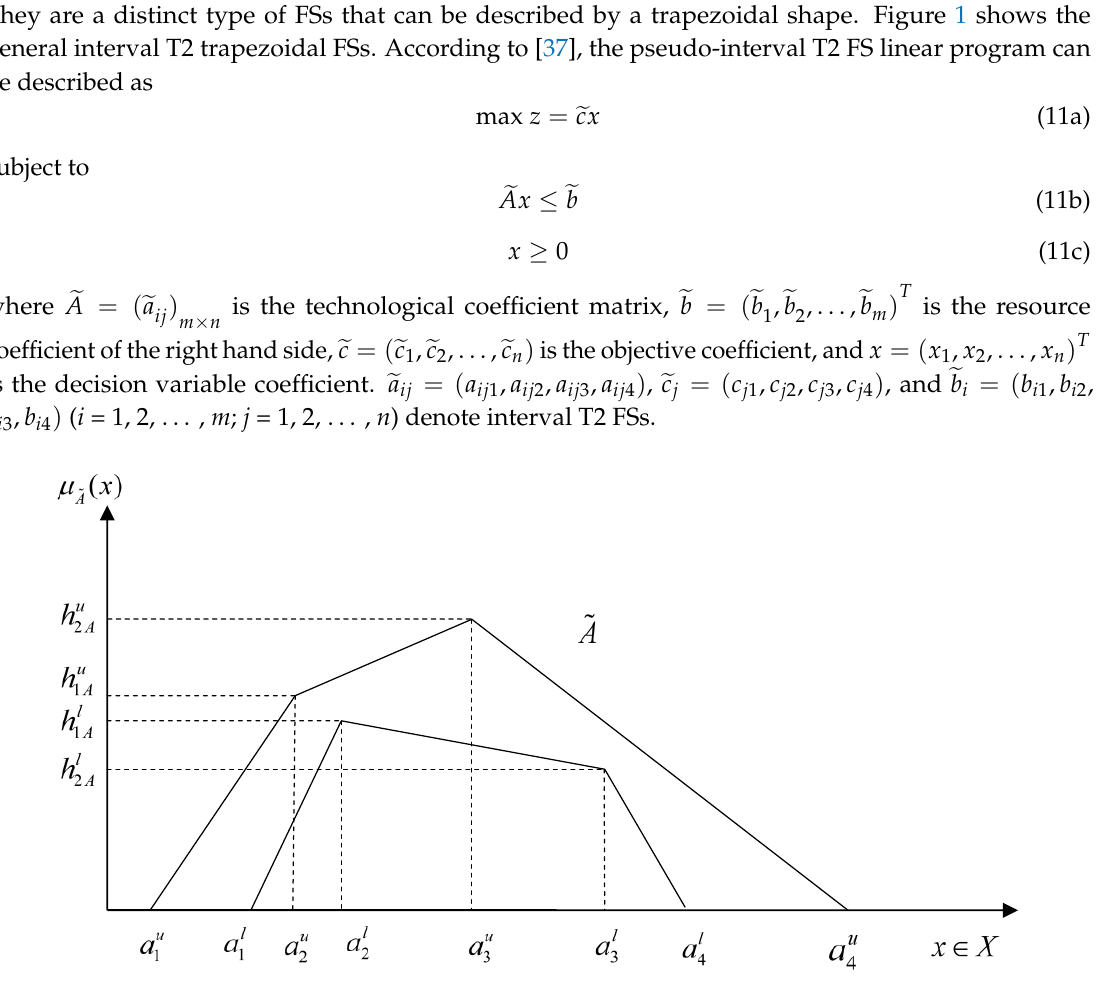
Figure 1. A general interval type 2 fuzzy set.